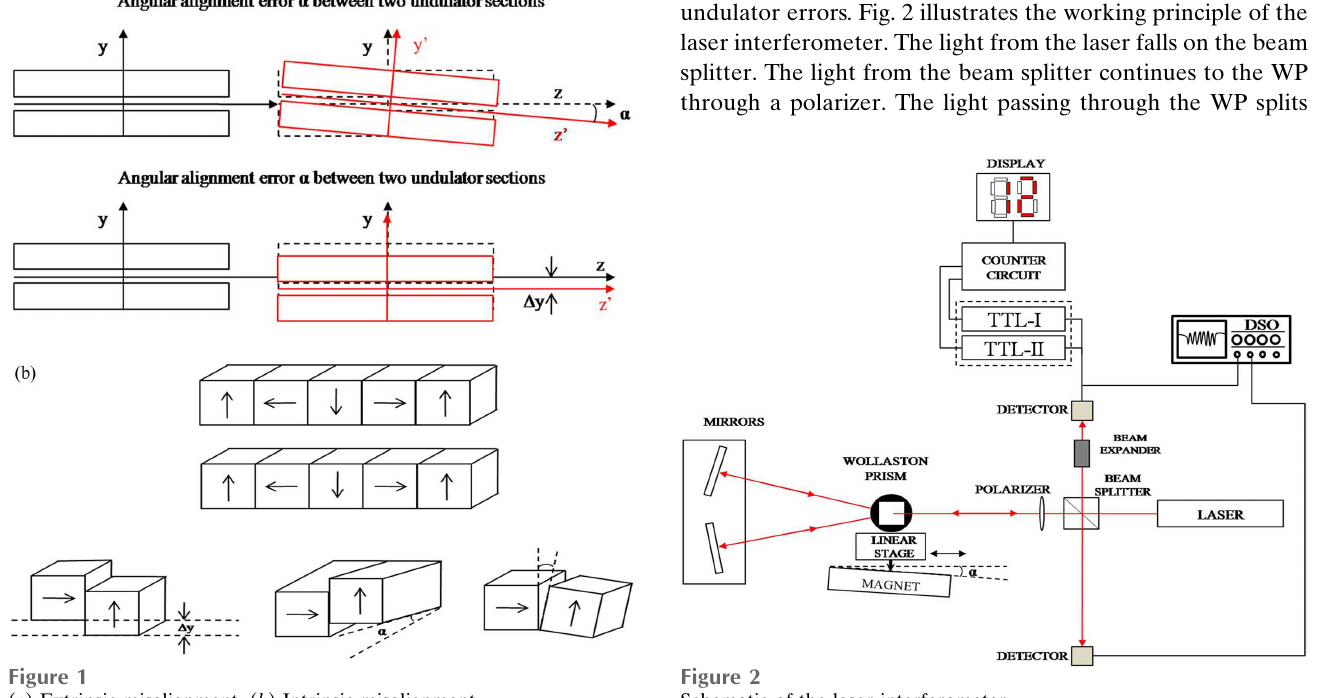
Figure 1 ( a ) Extrinsic misalignment. ( b ) Intrinsic